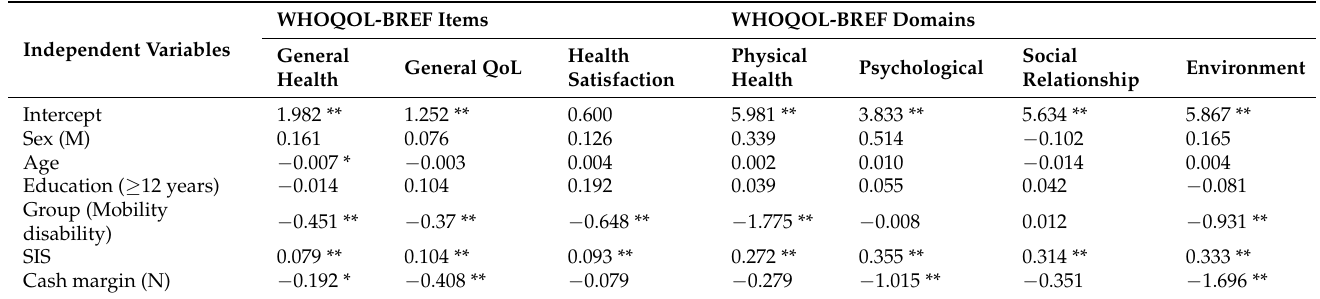
Table 6. Prediction of score change between independent variables and WHOQOL-BREF item and domain scores, whole group, generalized linear